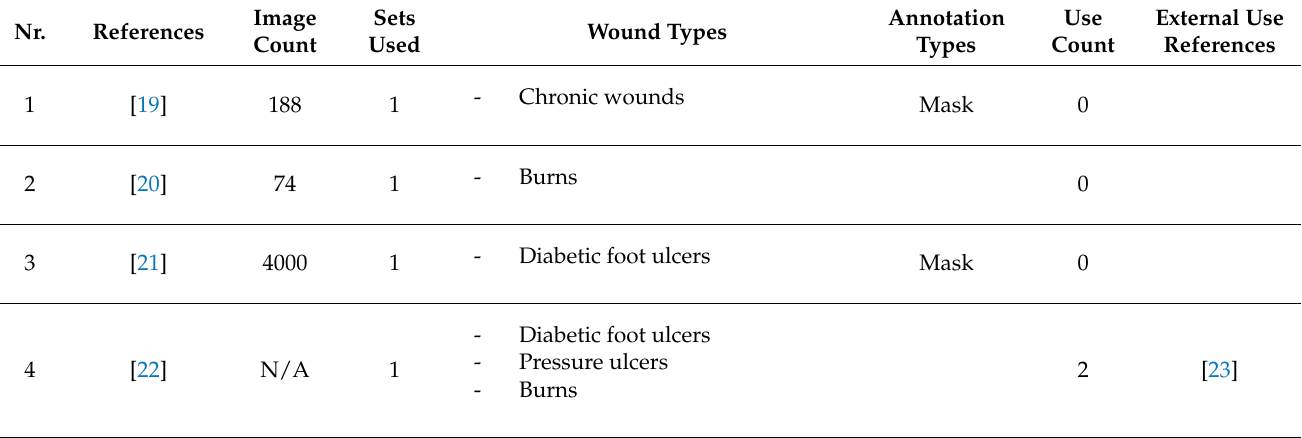
Table 3. Publicly available